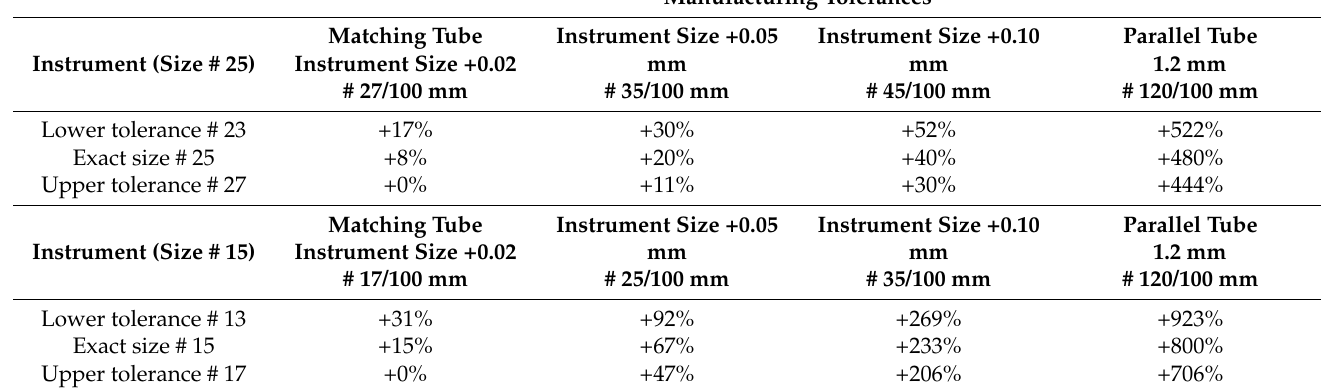
Table 2. Percentage increase in diameter between instrument tip and artificial canal sizes in relation to different instruments according to manufacturing